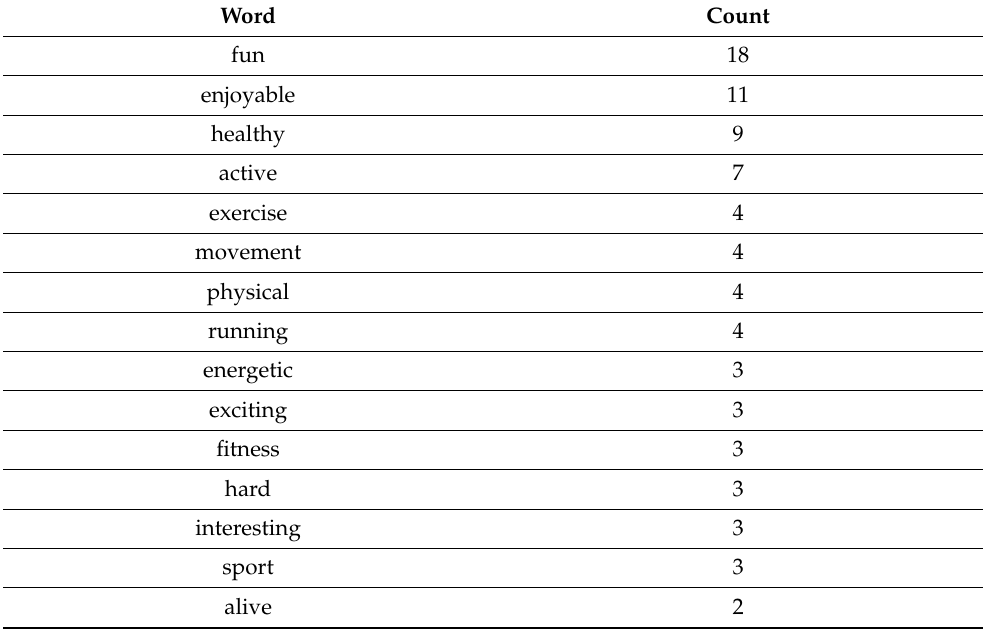
Table 2. Top 10 responses for the icebreaker